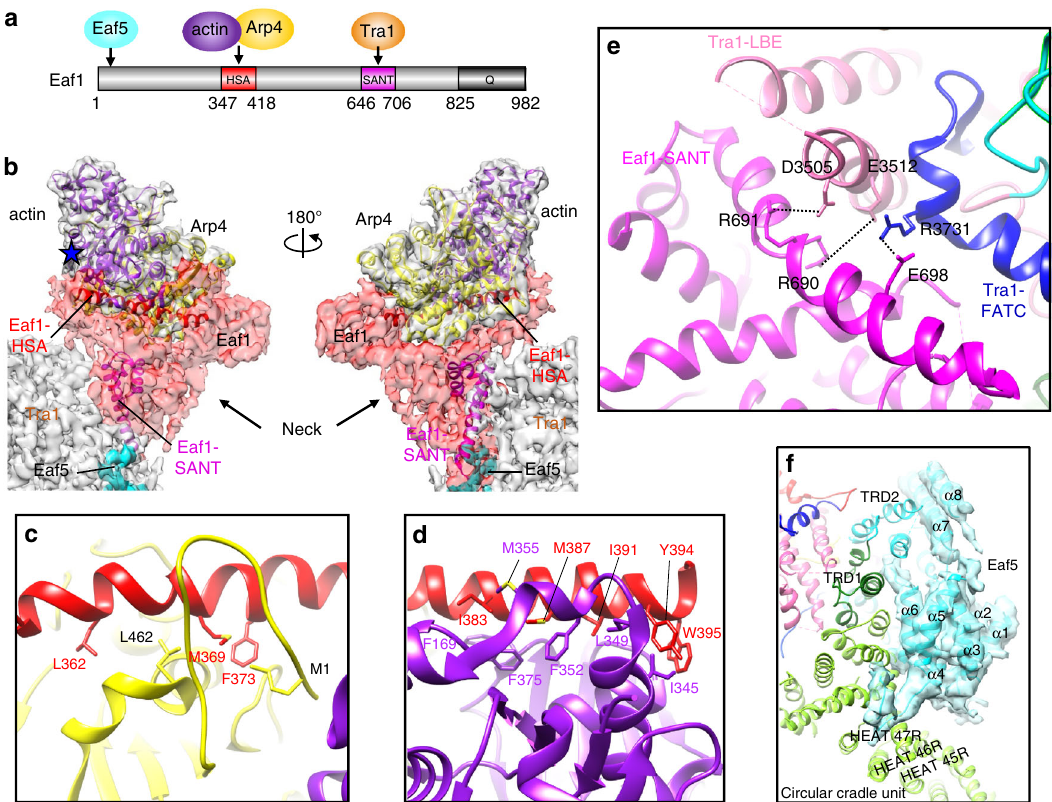
Fig. 4 Interaction between TEEAA subunits. a Domain architecture of Eaf1 is colored in red (HSA domain), magenta (SANT domain), dark gray (C-terminal rich-Q domain), and gray (other regions). b The cryo-EM density is shown as a translucent surface fi tted with the ribbon diagram model of actin, Arp4, Eaf1 HSA domain, and SANT domain. The Eaf1 density is shown as red translucent surface and the Eaf5 is shown in cyan solid surface. Both actin and Arp4 subunits directly interact with the HSA domain of Eaf1. The actin D2A mutation ( act1-136 mutant) is highlighted with a blue star. c HSA Eaf1 -Arp4 interaction. Three key hydrophobic residues of HSA Eaf1 (L362, M369, and F373) contact the hydrophobic M1 and L462 residues of Arp4. d HSA Eaf1 -actin interaction. Three key residues of HSA Eaf1 (I383, M387, and I391) are labeled, which contacts multiple hydrophobic residues in actin, including F169, F375, M355, F352, I345, and L349. e Interaction between Tra1 and Eaf1 subunits. The intermolecular hydrogen bonds between the SANT domain of Eaf1 and FATC and LBE domains of Tra1 are denoted with black dashed lines. f Interaction between Tra1 and Eaf5